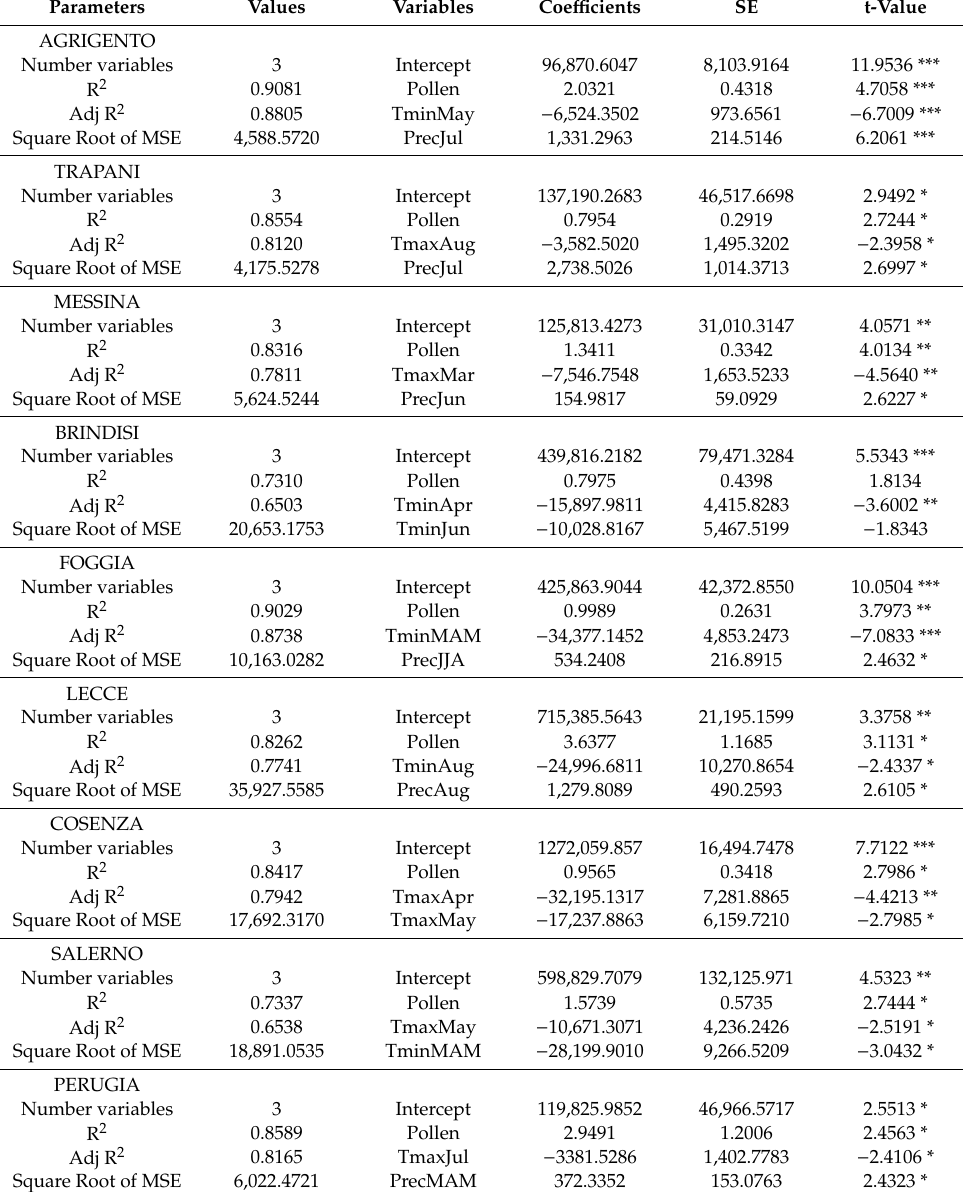
Table 2. Regression analysis for olive fruit production (dependent variable), with Annual Pollen Integral (Pollen) and environmental variables as independent variables. Only significant